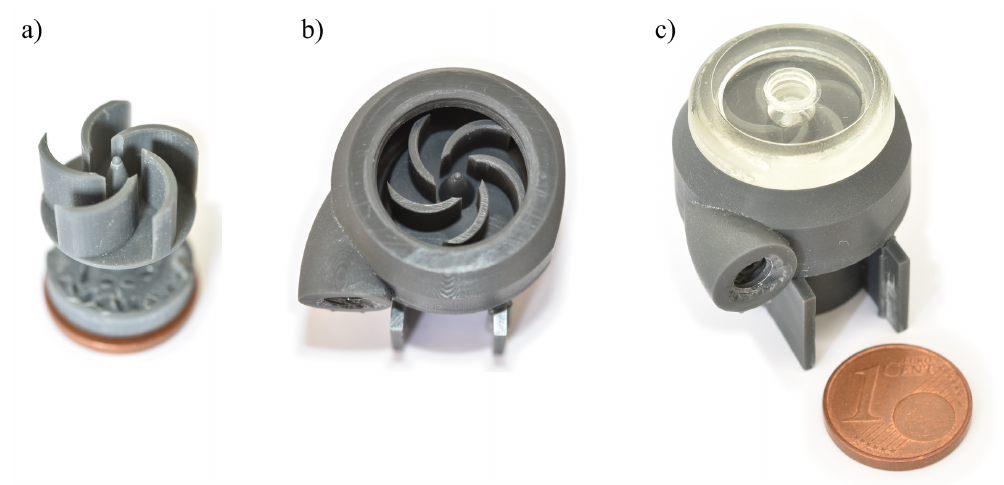
Figure 6. Photographs of ( a ) printed rotor with embedded magnets, ( b ) top view into pump chamber with inserted rotor and ( c ) complete pump with closed, transparent inlet lid and output connector on front. The overall width, depth and height of the pump is 28 mm × 30 mm × 24 mm,